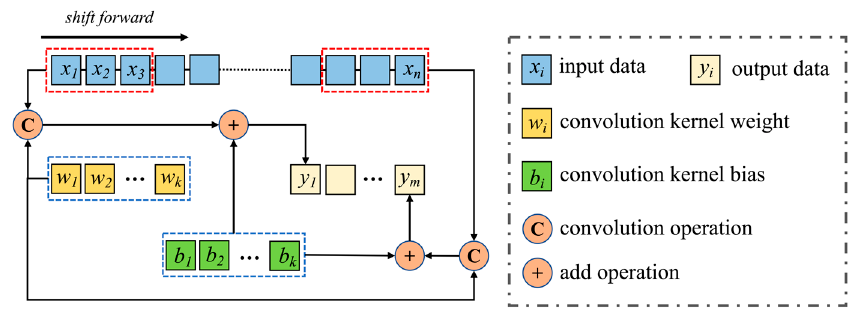
Figure 2. One-dimensional convolution operation.